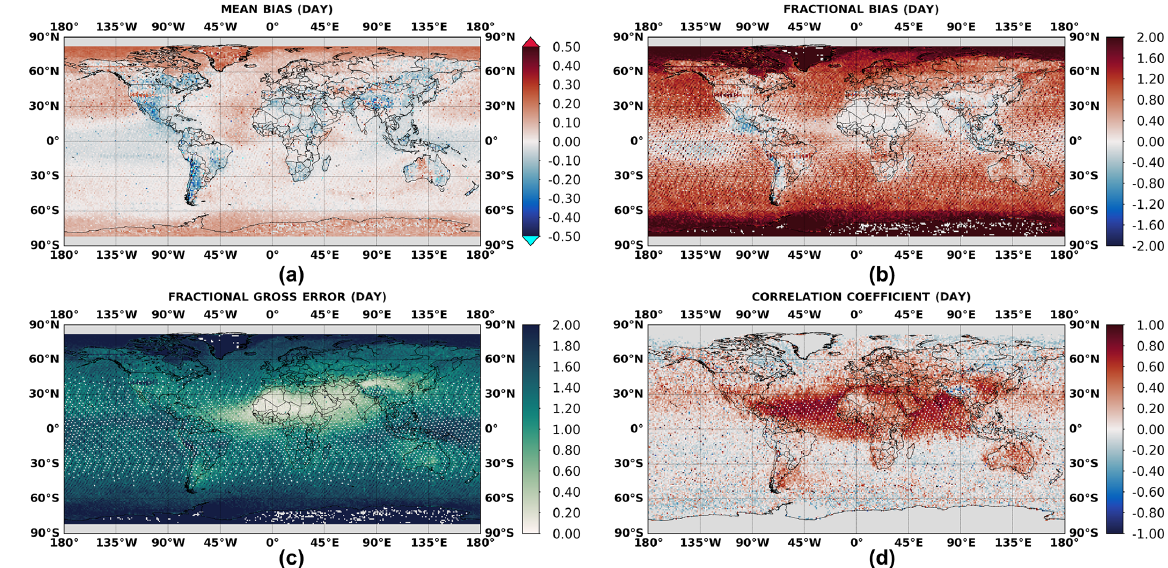
Figure 2. Annual geographical distributions illustrating the assessment of MDF versus LIVAS dust fraction, during daytime conditions, at 1 ◦ × 1 ◦ spatial resolution, according to the primary skill metrics of (a) mean bias, (b) fractional bias, (c) fractional gross error, and (d) correlation coefficient representative for the period